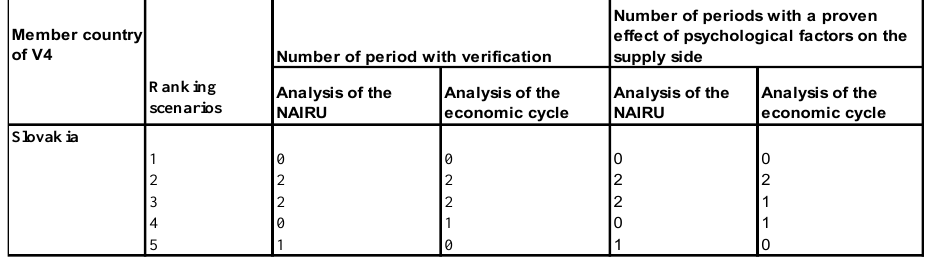
Table 2. The number of periods with verification and with demonstrated the influence of psychological factors on the supply side (the number of analysed period)